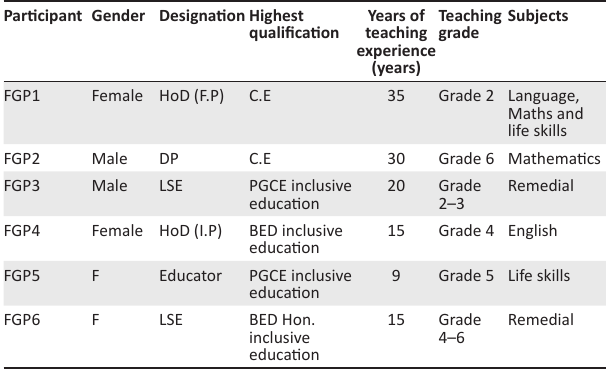
TABLE 2: Biographical details of school-based support team participants in focus group